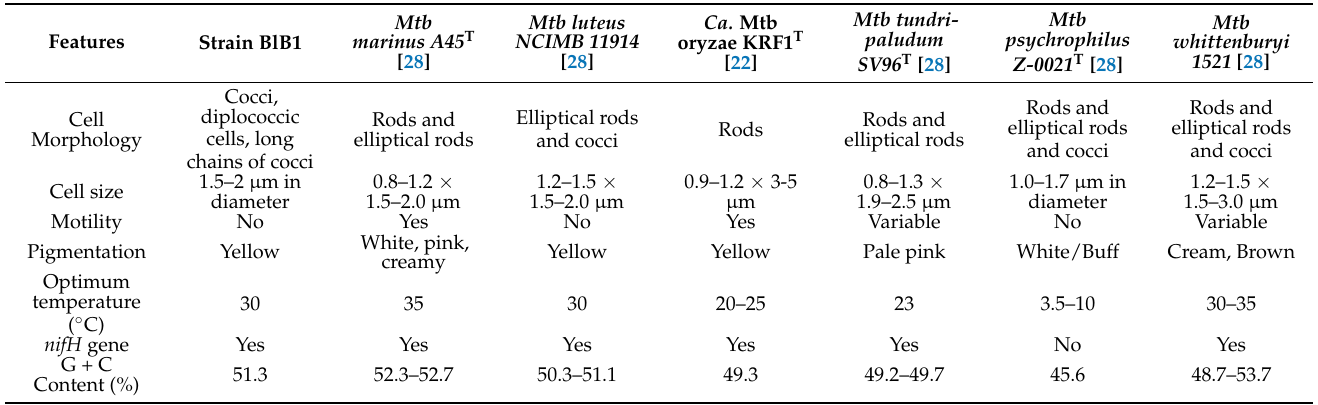
Table 3. Differential morphological and biochemical characteristics of Methylobacter species in comparison with strain BlB1.